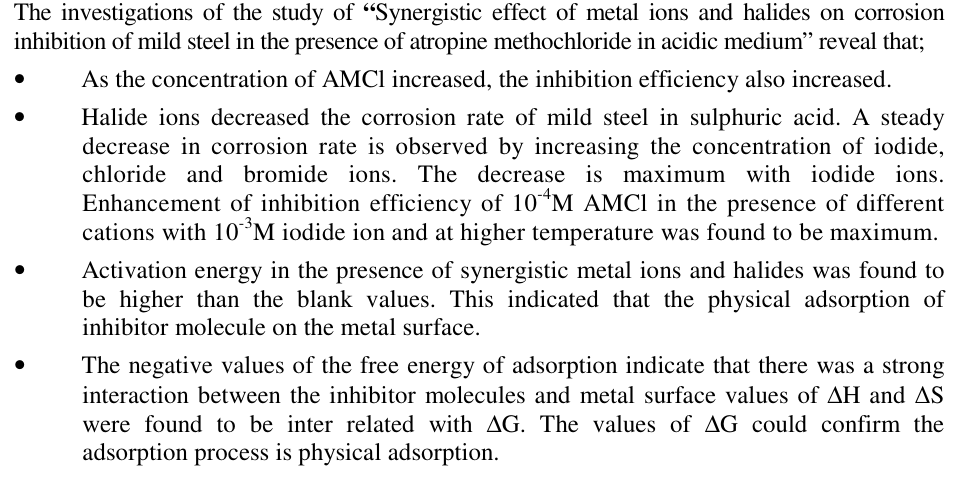
Table 11. Kinetic parameters of corrosion and thermodynamic parameters of adsorption of AMCl, I - and Cu 2+ ions for MS in 1M H